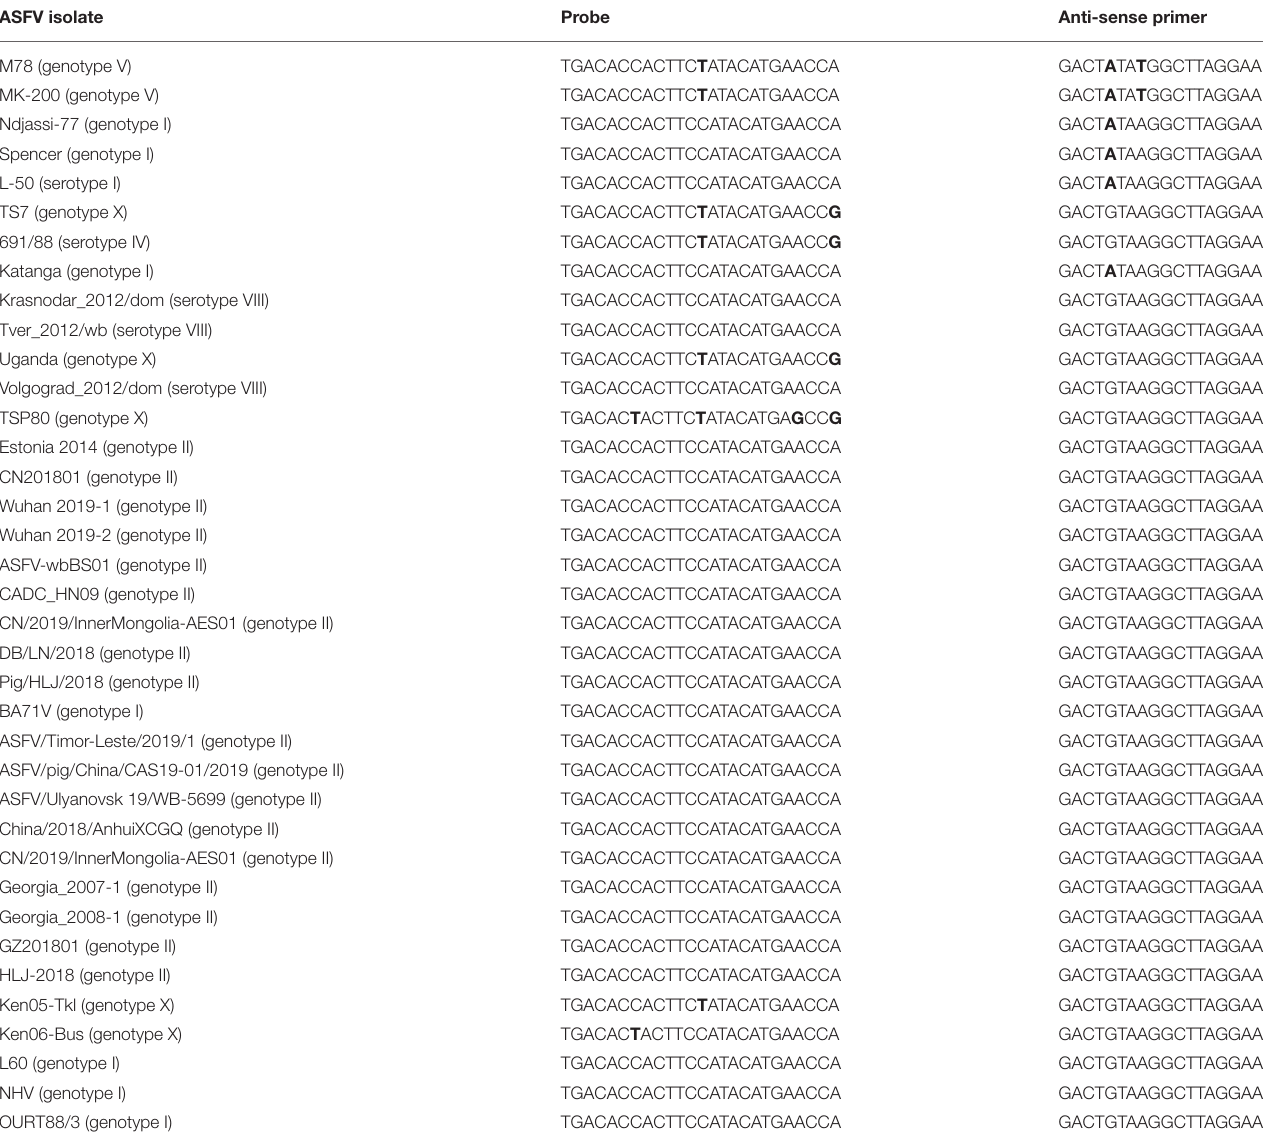
TABLE 2 | Primer and probe of EP402R were aligned with 37 African swine fever virus (ASFV)